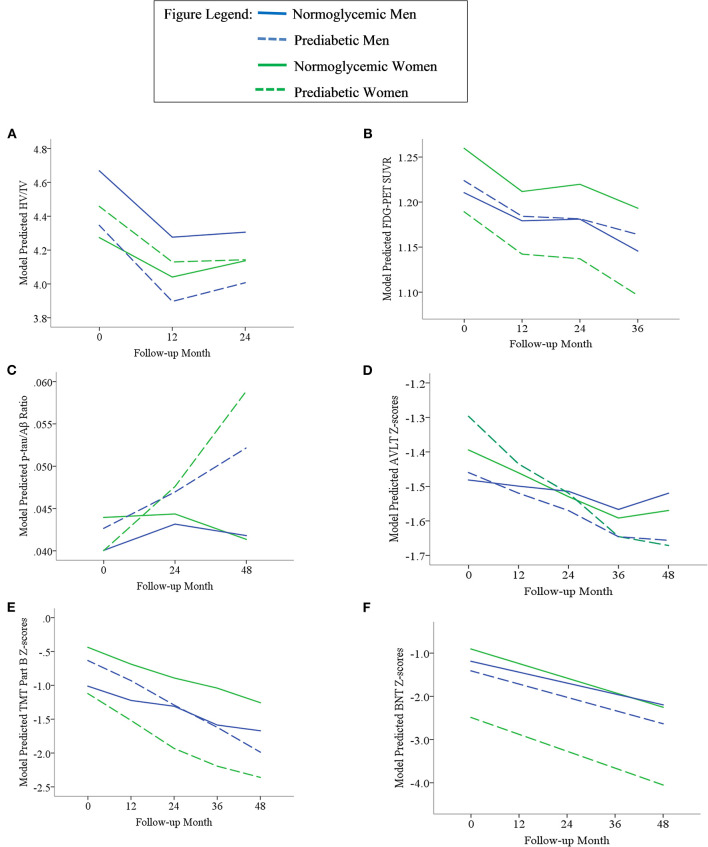
Trajectories of AD biomarkers (A–C) and cognitive test z-scores (D–F) by prediabetes status and sex in the MCI subsample. TMT Part B z-scores were multiplied by −1 so that higher scores indicated better performance. Z-scores are age- and education-adjusted based on a normative control group that remained cognitively normal throughout follow-up in ADNI. HV/IV, ratio of hippocampal volume to intracranial volume; PET, positron emission tomography; FDG, fludeoxyglucose; SUVR, standaradized uptake volume ratio; p-tau, phosphorylated tau; Aβ, amyloid beta; BNT, Bostin Naming Test; TMT, Trail Making Test; AVLT, Rey Auditory Verbal Learning Test.